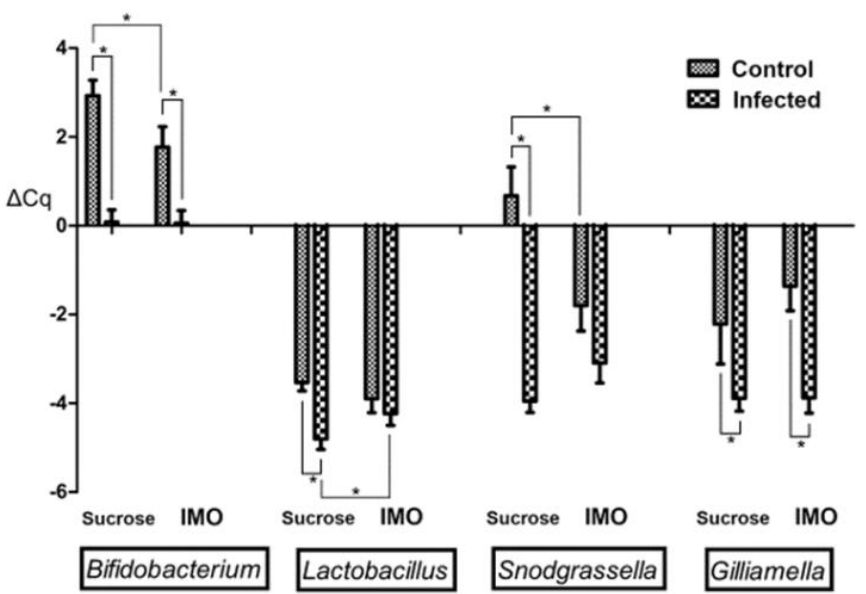
Figure 4. Relative qPCR results of the hindgut samples normalized using honey bee Beta-actin. The lower ∆ Cq values indicate higher bacteria populations. Significances are labeled by asterisks.